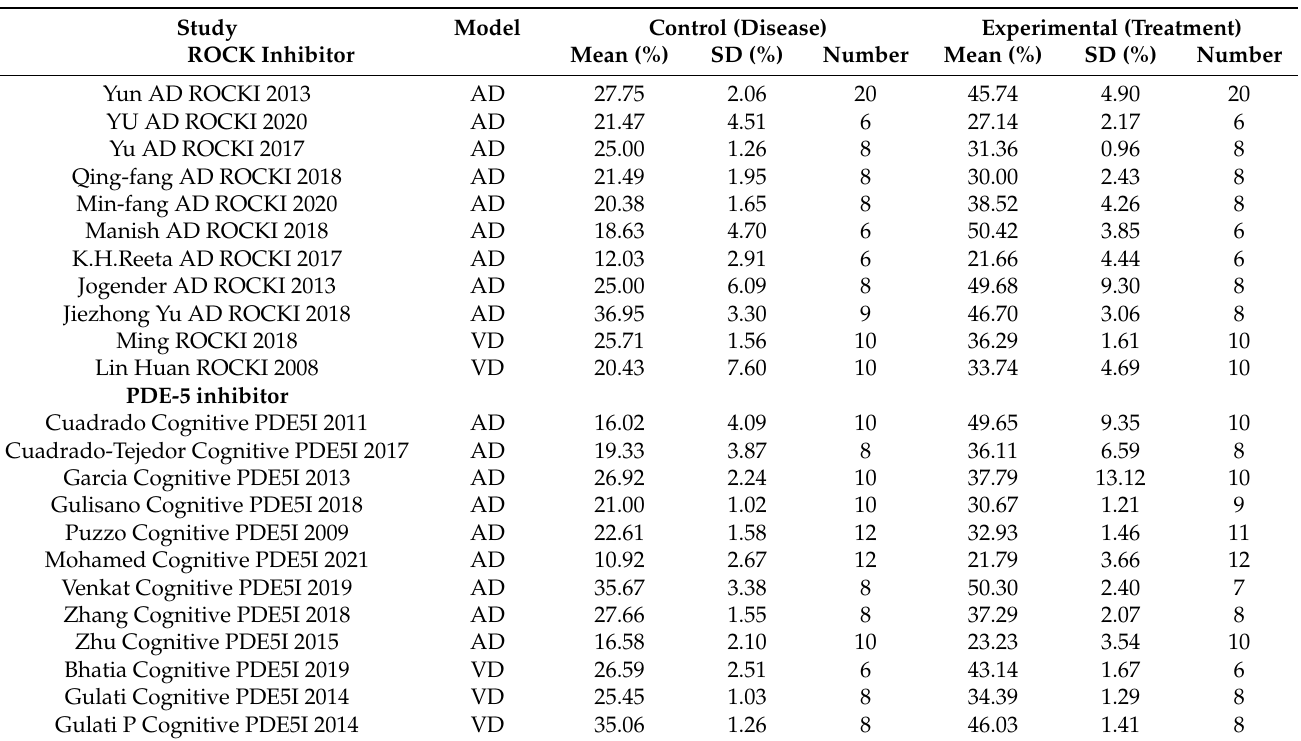
Table 3. Time spent in the target quadrant (%) during the Morris water maze investigation ex- tracted from each publication. The mean and standard deviation values and the populations of the experimental and control groups are